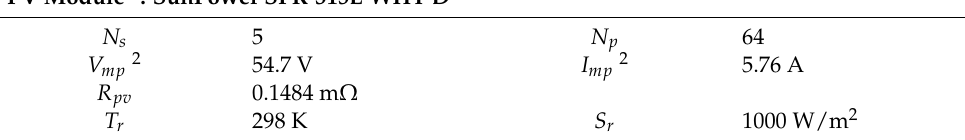
Table 2. PV parameters.